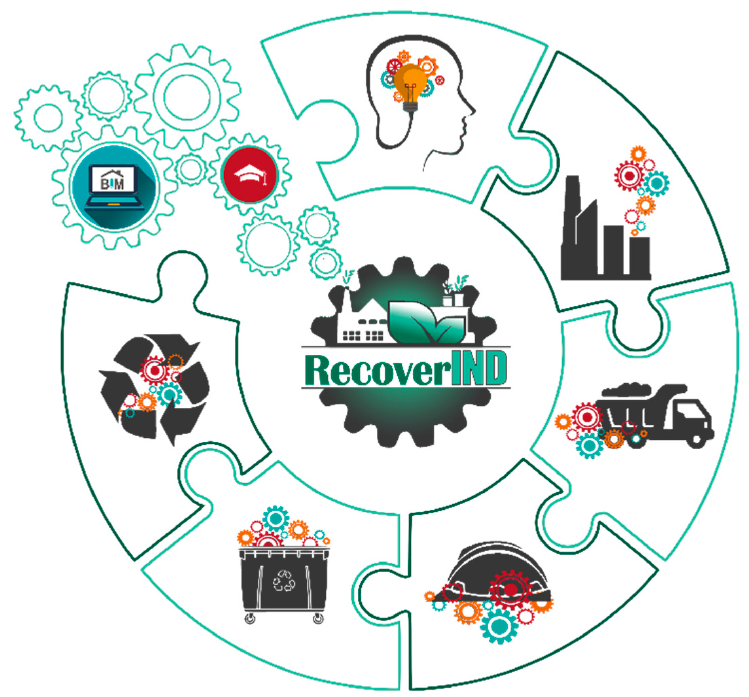
Figure 5. Homepage with the RecoverIND website menu for teaching tools [66]. Table 4. Bills of quantities of the three case studies according to the systematic classification defined in Table